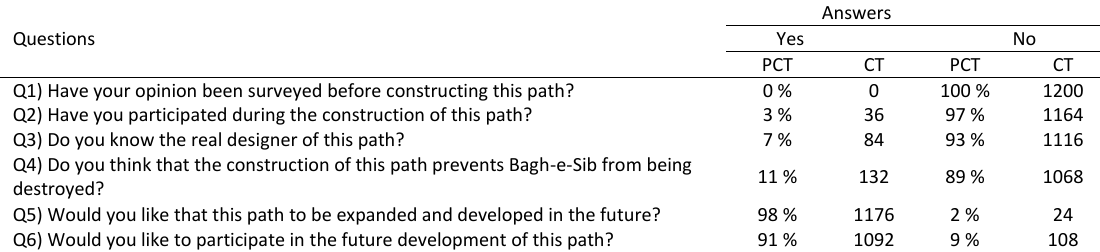
Table 4: Frequency percentages and counts for the number of respondents based on questions and their answers Questions